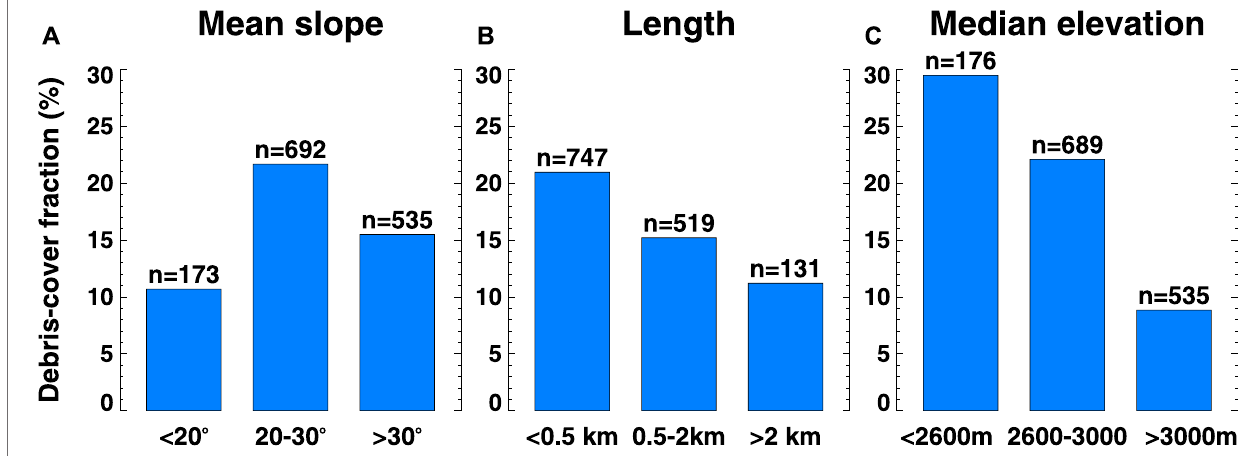
FIGURE 8 | Dependence of the arithmetic mean of the glaciers ’ debris-cover fraction on classes of topographic parameters: (A) mean surface slope, (B) glacier length, and (C) median elevation. The number of glaciers per class ( n ) is given.